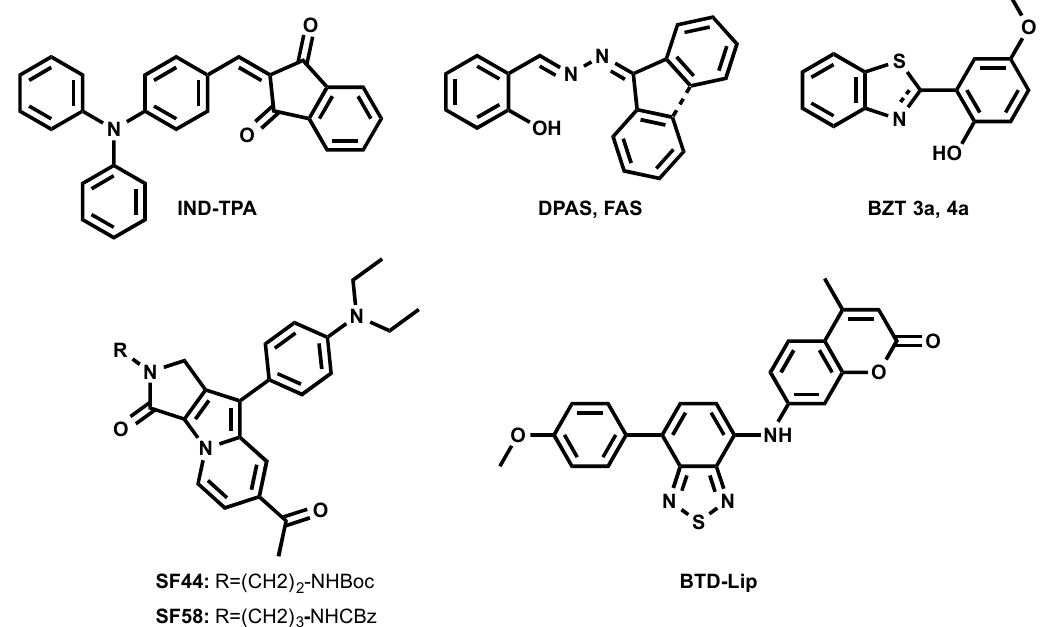
Figure 5. Chemical structures of orange-emitting LD probes.